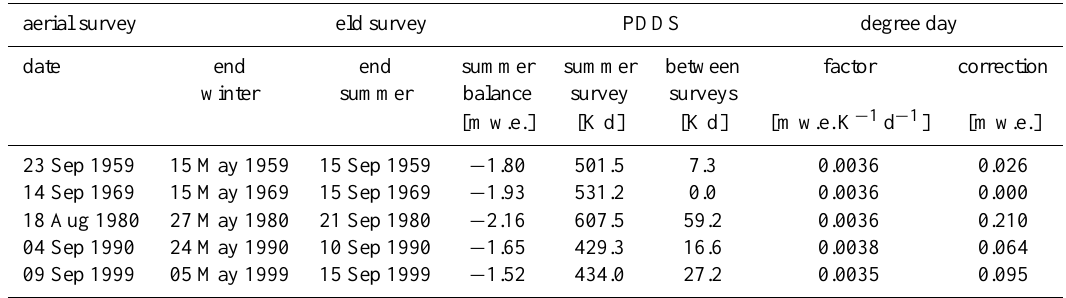
Table 1. Aerial and field survey dates, positive degree day sums (PDDS), related melt factors and resulting absolute melt corrections. The volumetric mass balance of 1969–80, for example, requires additional melt of 0.210mw.e. in order to fit the field survey period. A corresponding correction for the beginning of the period is not required as there are no positive degree days recorded between the surveys. For more details see